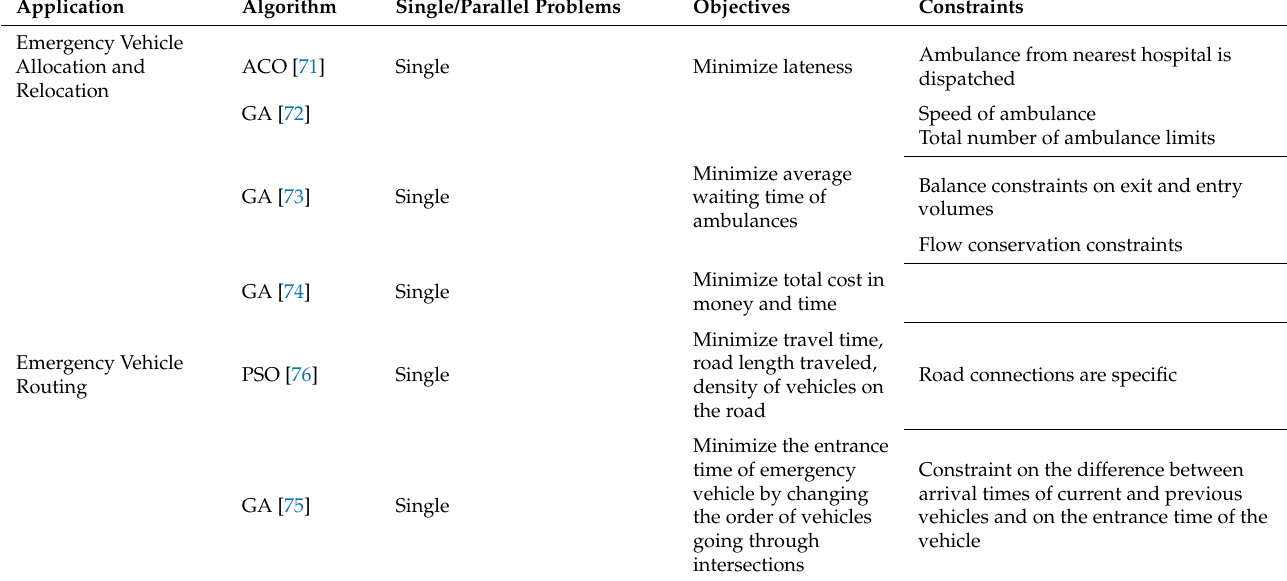
Table 7. Optimization in Smart